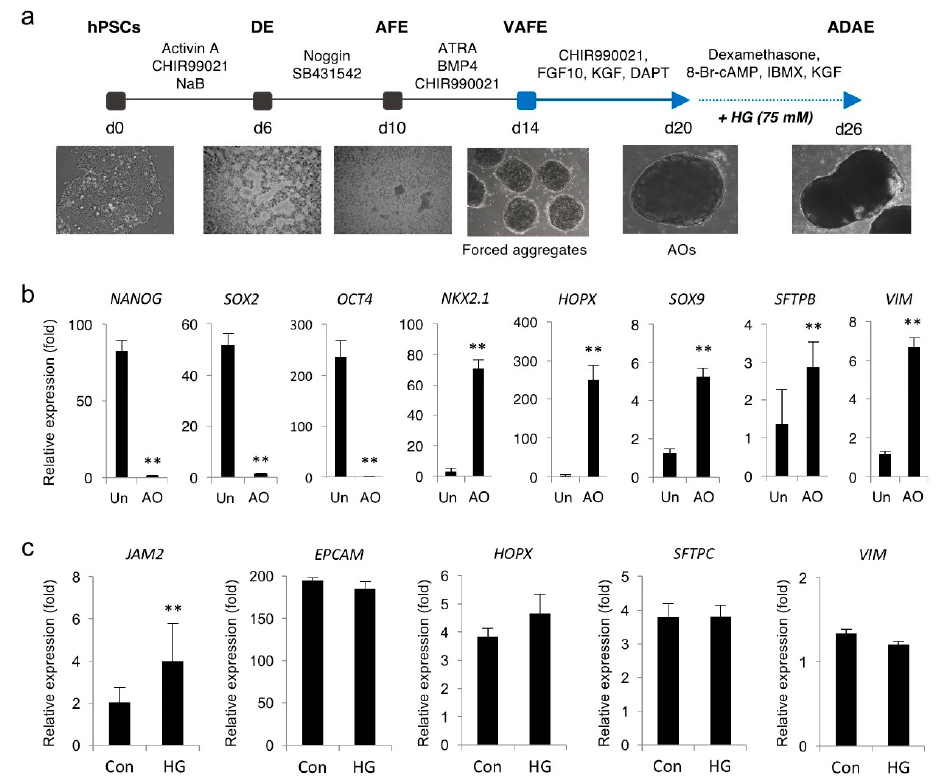
Figure 5. High glucose upregulated JAM2 expression in human AOs. ( a ) Schematic overview of the generation of AOs from hPSCs. ( b ) qPCR of the indicated pluripotency and AEC markers in AOs. Data are shown as fold-change relative to undifferentiated hPSCs (Un). Data are presented as mean ± SD. ** p < 0.01. ( c ) qPCR analysis of JAM2 and AEC markers in the control (17.5 mM) and HG (75